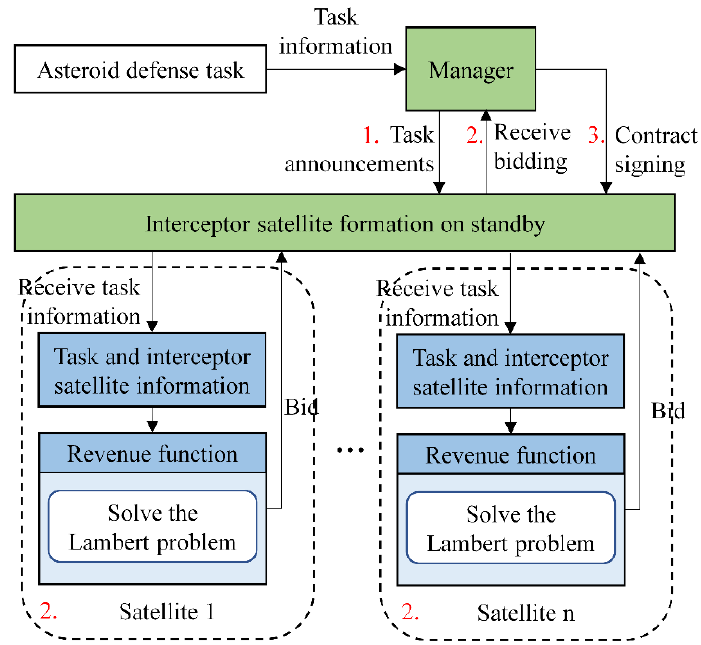
Figure 4. Schematic diagram of the improved contract net protocol algorithm.